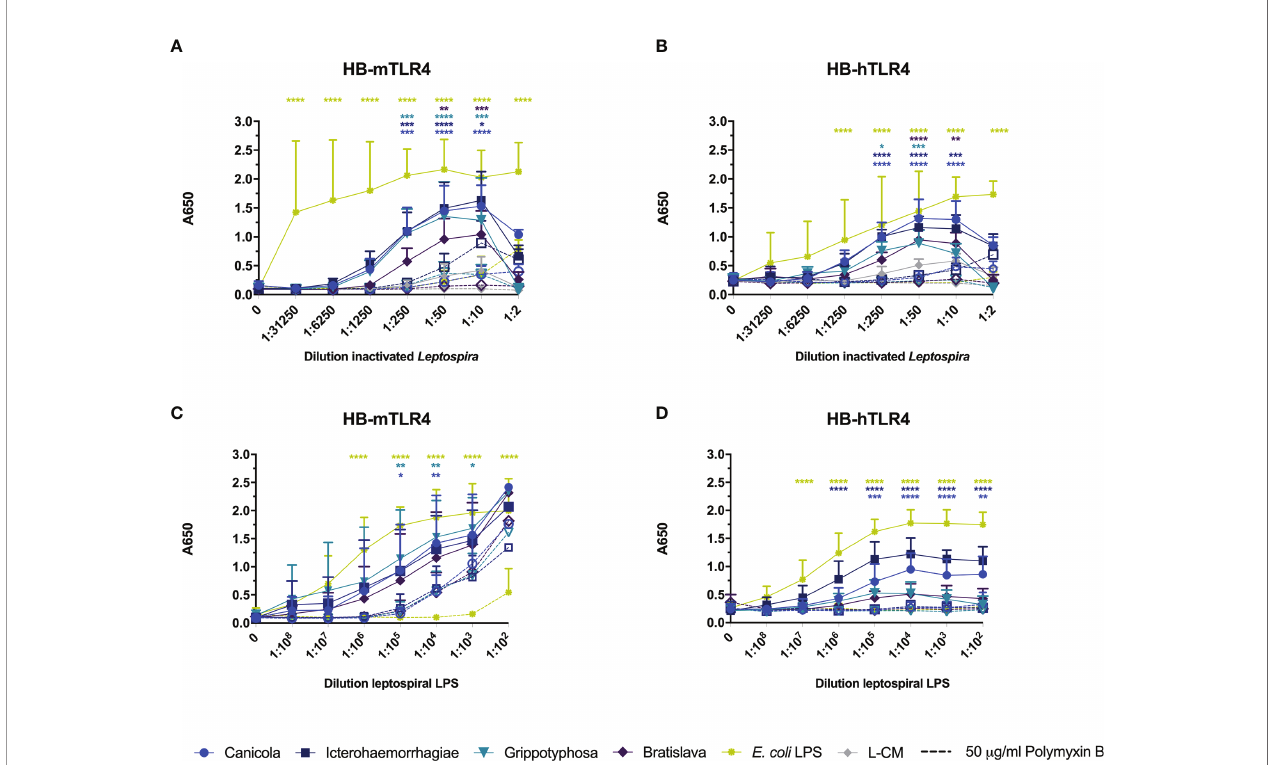
FIGURE 4 | Leptospiral LPS dose-dependently activates mouse and human TLR4. HEK-Blue reporter cell lines expressing (A, C) mouse (HB-mTLR4) and (B, D) human (HB-hTLR4) TLR4 were stimulated with serially diluted E. coli LPS (yellow) or leptospiral culture medium (L-CM; grey) as positive and negative control, respectively or serially diluted whole-inactivated L. interrogans serogroup Canicola (circle), Icterohaemorrhagiae (square) or Bratislava (diamond) or L. kirschneri serogroup Grippotyphosa (triangle) (A, B) or leptospiral LPS isolated from the same serogroups (C, D) . Puri fi ed leptospiral LPS and E. coli LPS were diluted 10-fold with a starting concentration 0.56 nmol/ml and 10 µg/ml, respectively. Dotted lines with open symbols represent stimulations that were pre-treated with polymyxin B, at a fi nal concentration of 50 µg/ml polymyxin B in cell culture. Mean values from three independent assays per cell line are shown. Each assay was performed using two or three replicates per condition. The error bars represent the SD. A mixed-effect analysis combined with Tukey ’ s multiple comparisons test was used to test for signi fi cance between the untreated and polymyxin B treated stimulus at each dilution. In addition, serogroup Canicola and Icterohaemorrhagiae derived LPS appeared as a signi fi cantly stronger activator of human TLR4 compared to LPS derived from serogroups Grippotyphosa or Bratislava. *p < 0.05, **p < 0.01, ***p < 0.001, ****p <